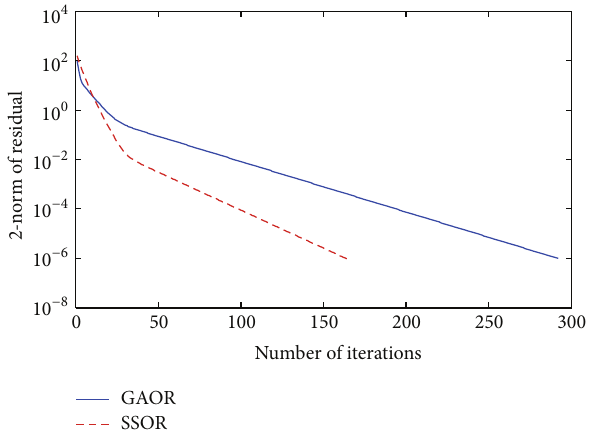
Figure 1: Comparison between GAOR method and SSOR